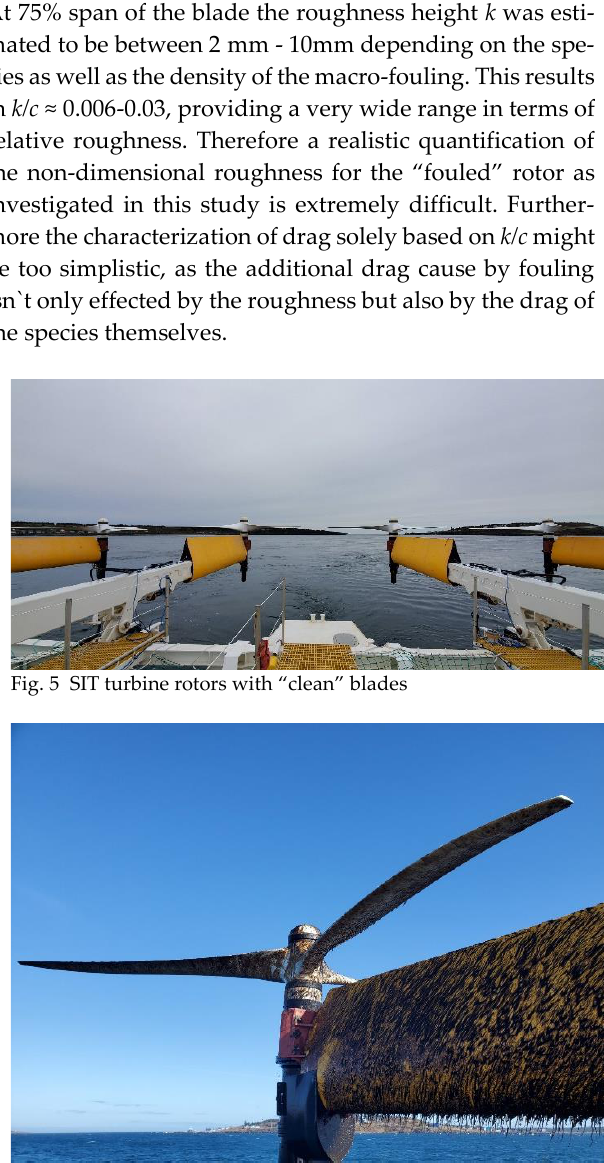
Fig. 6 SIT 4 rotor with “fouled” blades